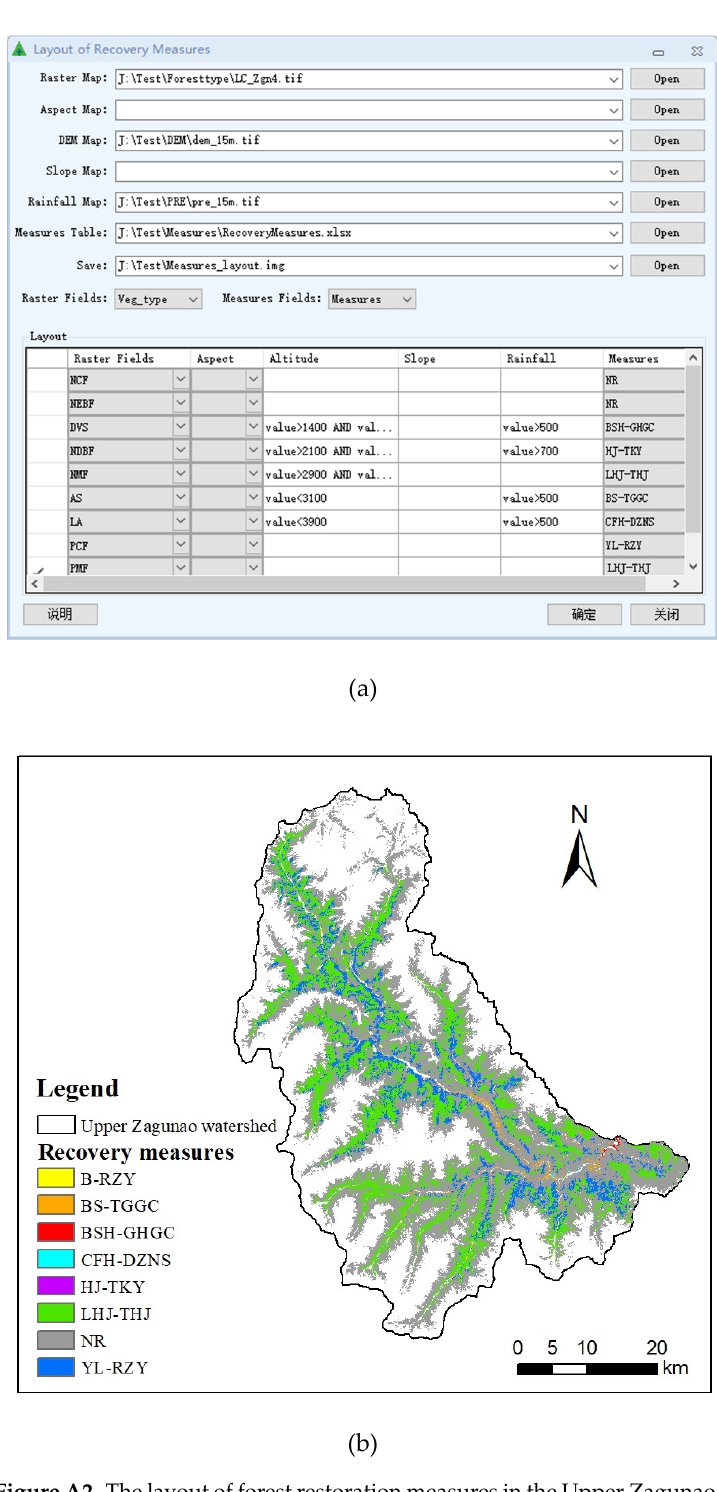
Figure A2. The layout of forest restoration measures in the Upper Zagunao watershed. ( a ) Parameters input; and ( b ) the results from FWAT. B-RZY, restoration measure for Cupressus chengiana ; BS-TGGC, restoration measures for severely degraded shrub lands in alpine canyon; BSH-GHGC, restoration measures for shrub lands in humid and fertile areas in dry valleys; CFH-DZNS, restoration measures for landslide and earthquake damaged slopes; HJ-TKY, restoration measures for Arrow Bamboo and Betula platyphylla secondary forest; LHJ-THJ, restoration measures for Fargesia, betula and Abies faxoniana natural mixed forest; NR, natural recovery; YL-RZY, technology of restoration measures for Picea plantation.